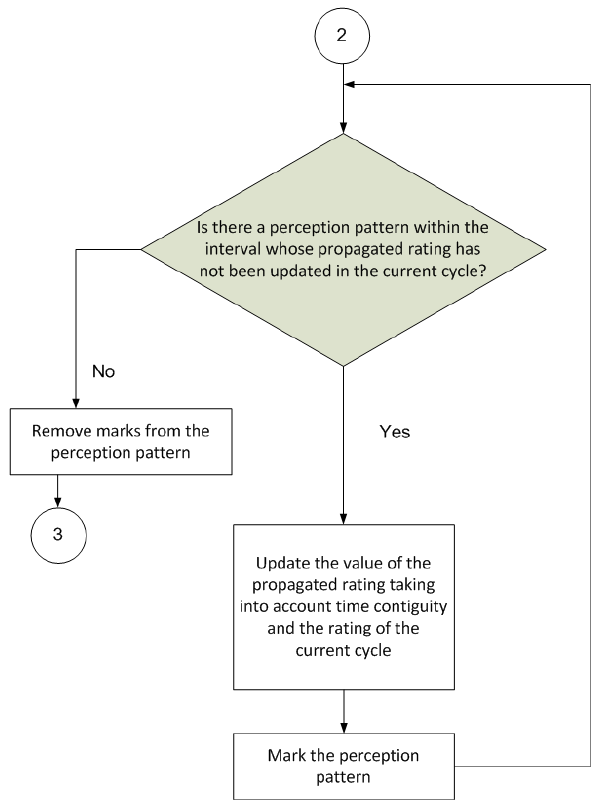
Figure 5. Rating back-propagation (2 is the initial state of this diagram; state 3 continues in Figure 6).